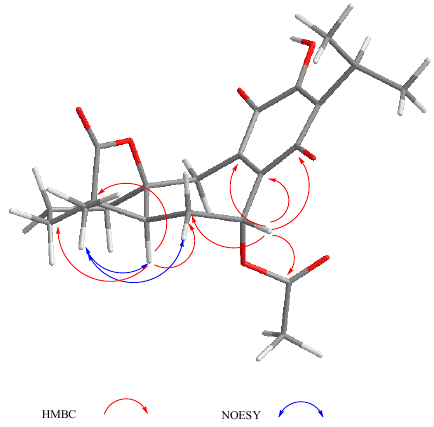
Figure 4. Selected correlations for compound 3 .